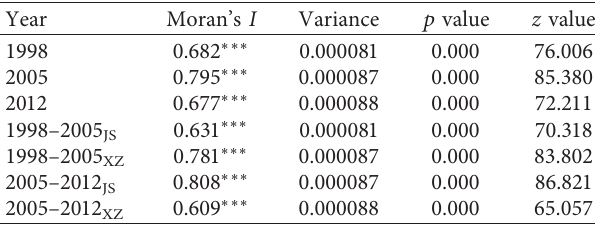
Table 2: Moran’s I values with spatial autocorrelation